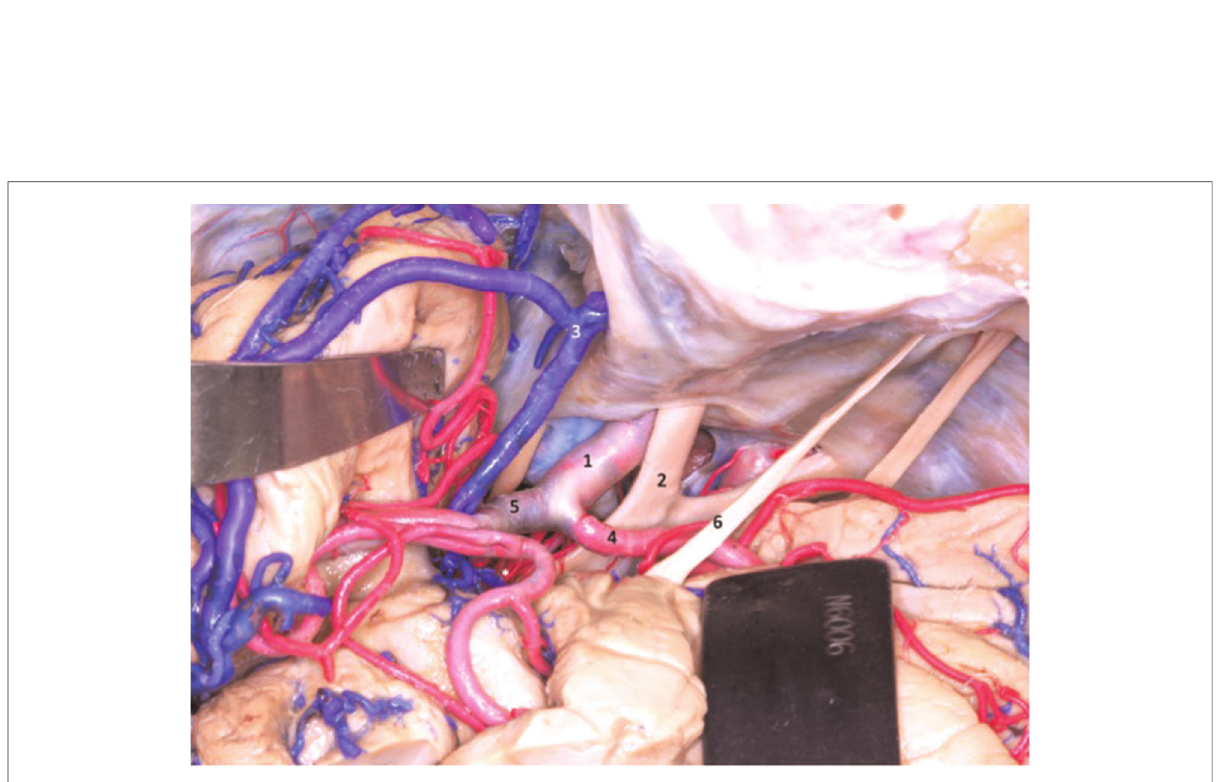
FIGURE 6 At the beginning of the transsylvian dissection to access the lobe of the insula, the internal carotid (1), anterior cerebral (4) and middle cerebral (5) arteries are exposed. Super fi cial sylvian complex vein draining into the sphenoparietal sinus (3). 1 - internal carotid artery; 2 - optic nerve; 3 - sphenoparietal venous sinus; 4 - anterior cerebral artery; 5 - middle cerebral artery; 6 - olfactory